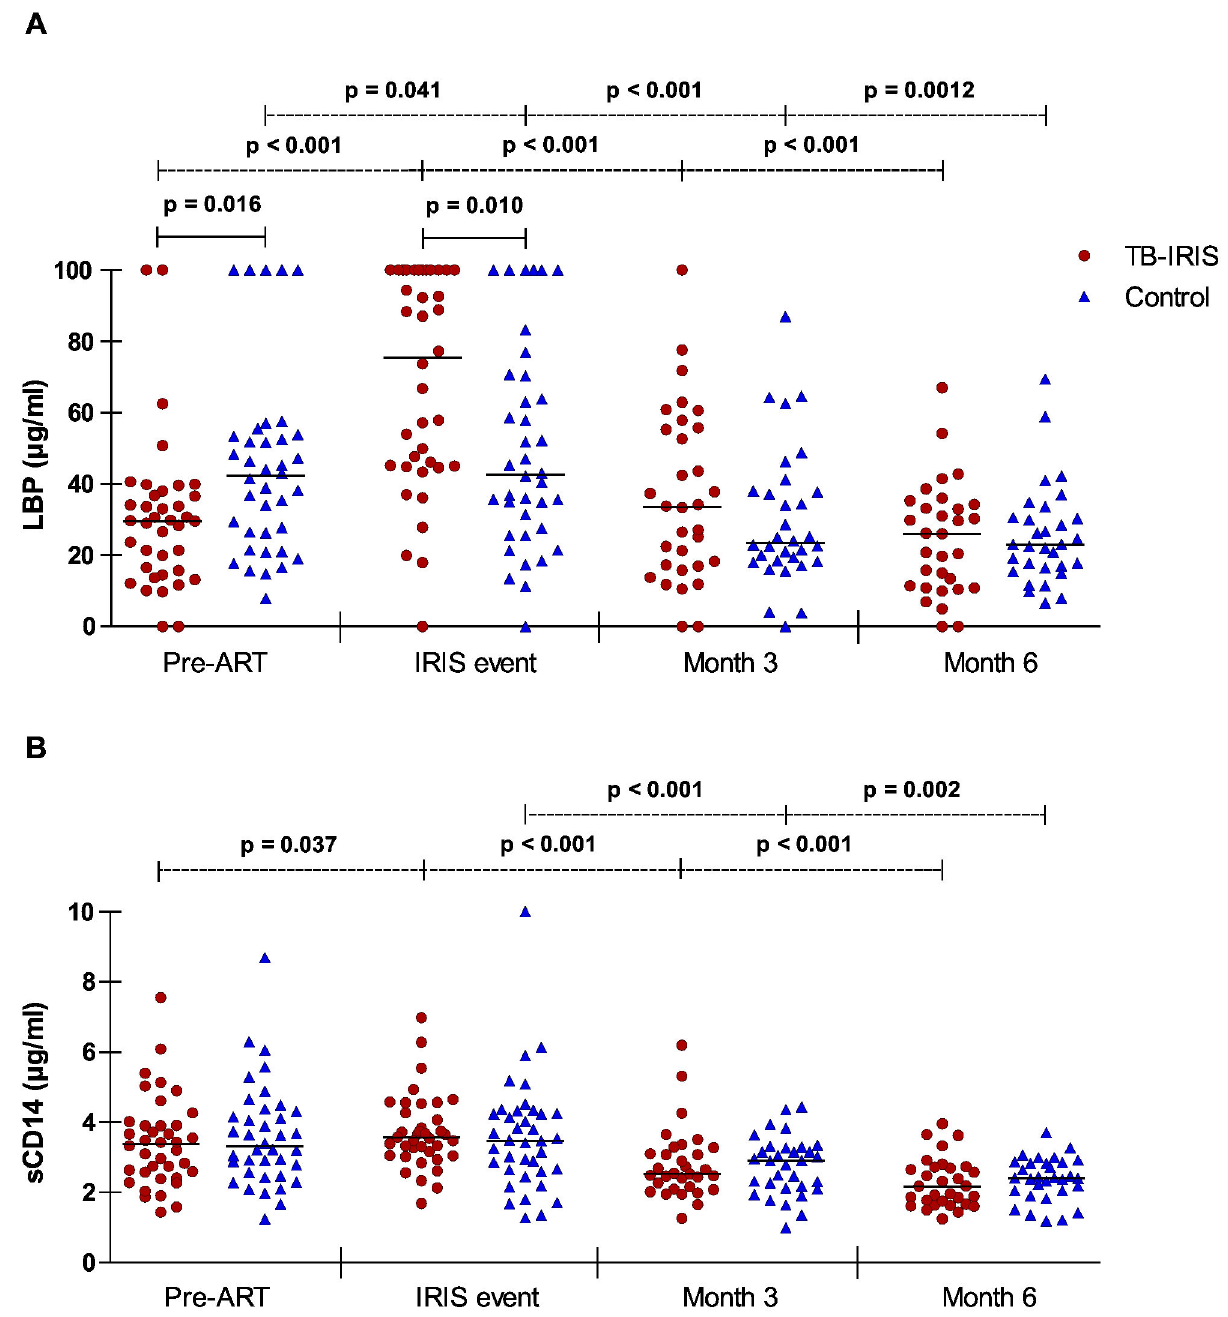
Figure 2. LBP and sCD14 plasma levels in TB-IRIS patients and controls during follow-up. Horizontal lines represent median levels of LBP (A) and sCD14 (B) for each patient group at each time point. A Wilcoxon signed-rank test was used to calculate p values. The level of significance was set to p < 0.05. Dotted lines indicate significant changes over time per patient-group and full lines indicate significant differences between matched patients. Number of patients in each group during consecutive time points is 38, 38, 32 and 31